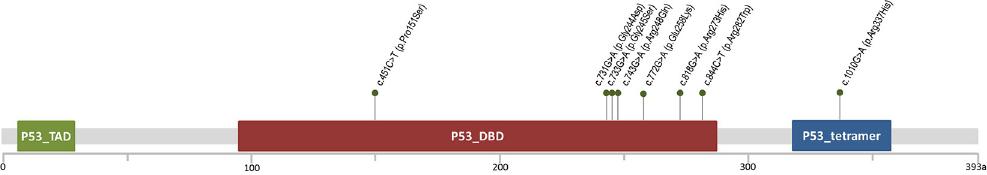
Fig 1. Location of the TP53 pathogenic variants detected in the p53 protein functional domains. Green dots represent the variants identified in the present study. P53_TAD, transactivation domain; P53_DBD, DNA binding domain; P53_oligomer, oligomerization